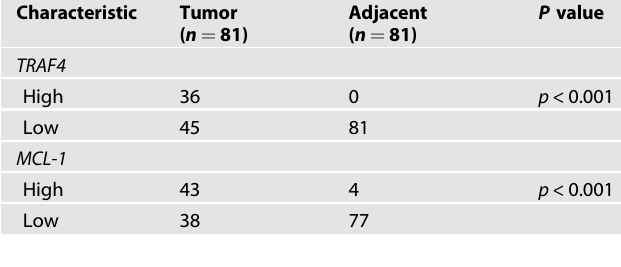
Table 1. Quanti fi cation of TRAF4 and MCL-1 protein levels in normal and OSCC tissues.